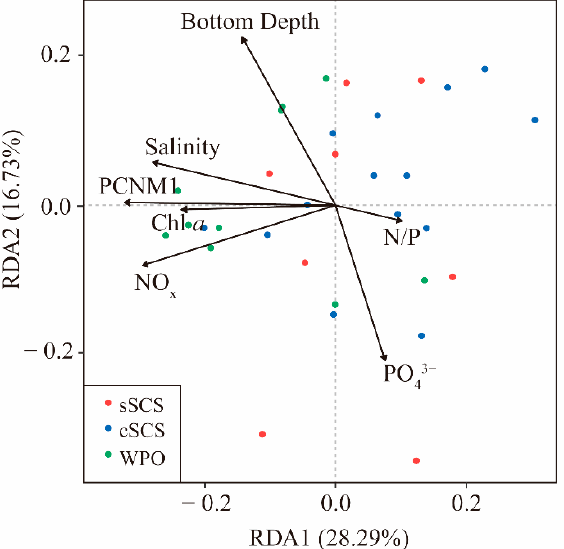
Figure A5. The transformation-based redundancy analysis (tb-RDA) is used to evaluate the effect of environmental fluctuations on the composition of diazotrophic communities in the SCS and the WPO.